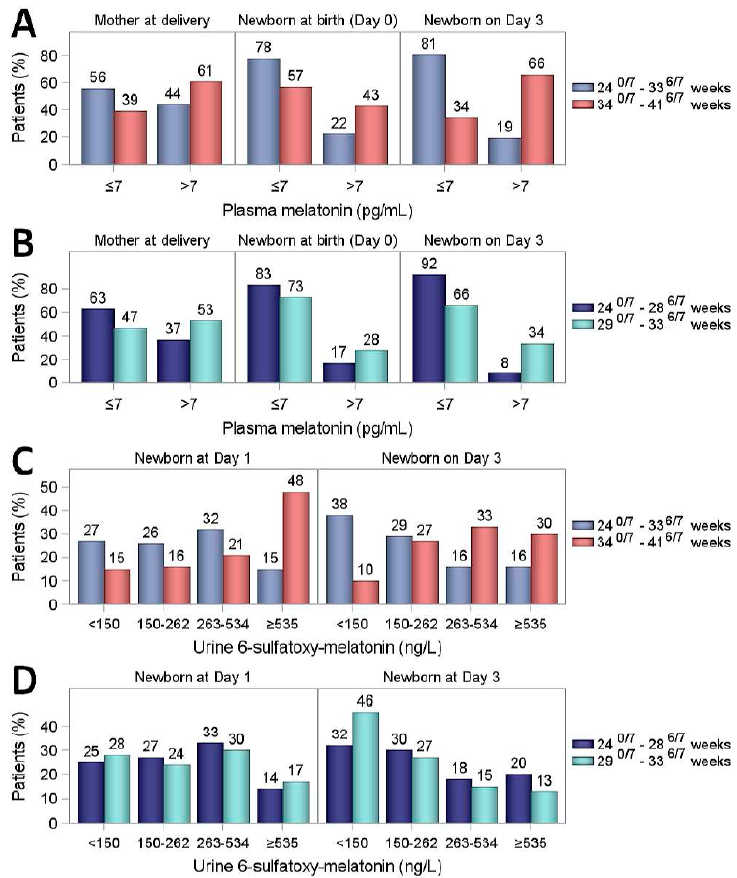
Figure 1. Distribution of plasma melatonin and urine a6MTs concentrations. ( A ) Plasma melatonin concentrations (pg / mL) in mothers at delivery, and the overall population recruited, split into 2 concentrations ranges ( ≤ 7 pg / mL, threshold of detectability, and > 7 pg / mL). ( B ) Plasma melatonin concentrations (pg / mL) in infants born between 24 0 / 7 and 33 6 / 7 gestational weeks (GW), split into 2 groups (24 0 / 7 –28 6 / 7 GW and 29 0 / 7 –33 6 / 7 GW). ( C ) Urine a6MTs concentrations (ng / L) in the overall population. ( D ) Urine a6MTs concentrations (ng / L) in infants born between 24 0 / 7 and 33 6 / 7 GW, split into 2 groups (24 0 / 7 –28 6 / 7 GW and 29 0 / 7 –33 6 / 7